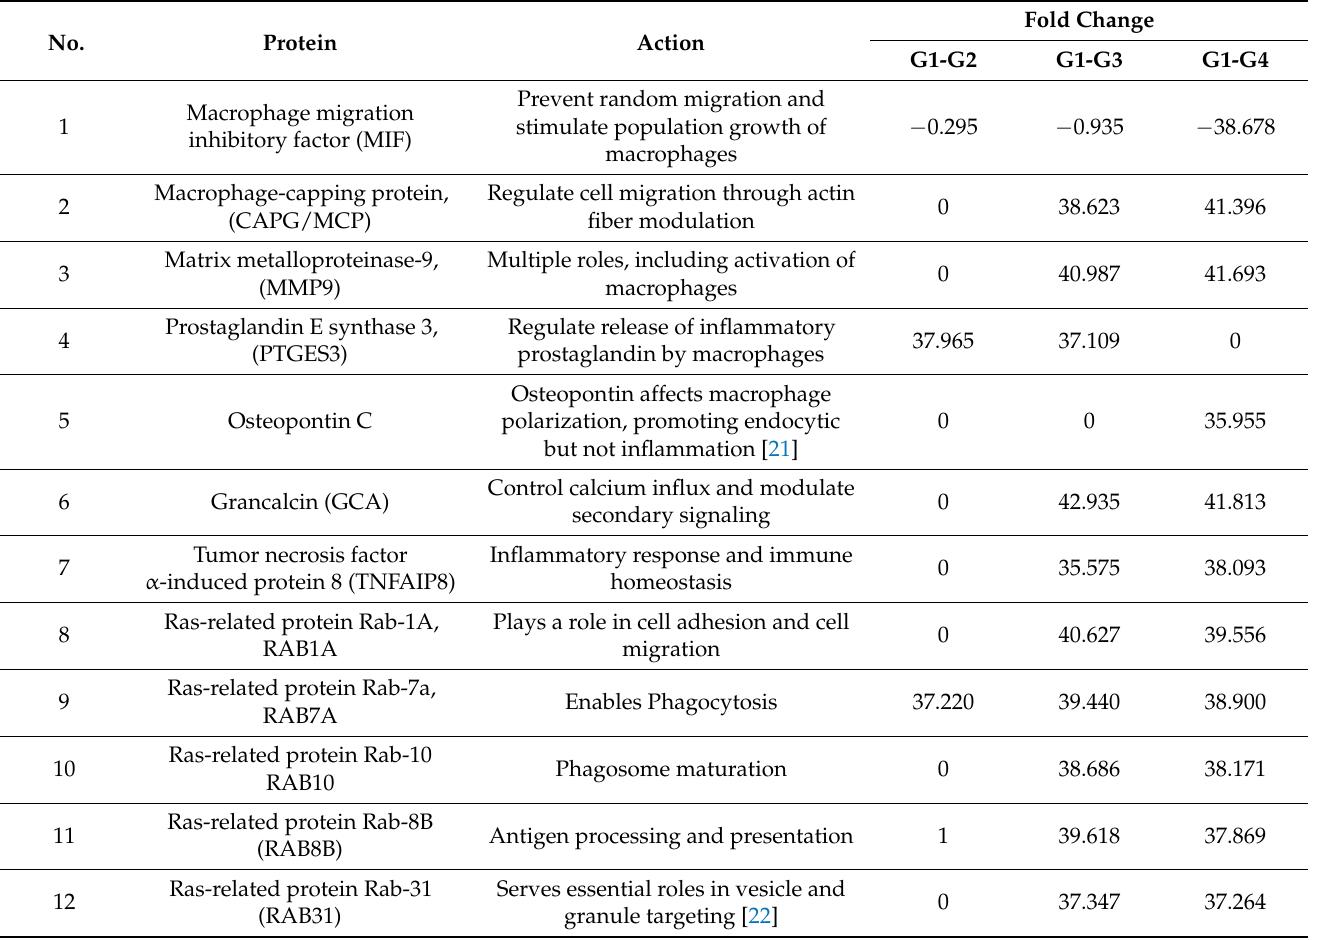
Table 1. A grade-wise demonstration of key proteins found in the proteome analysis of OA SFs, which are linked with macrophage